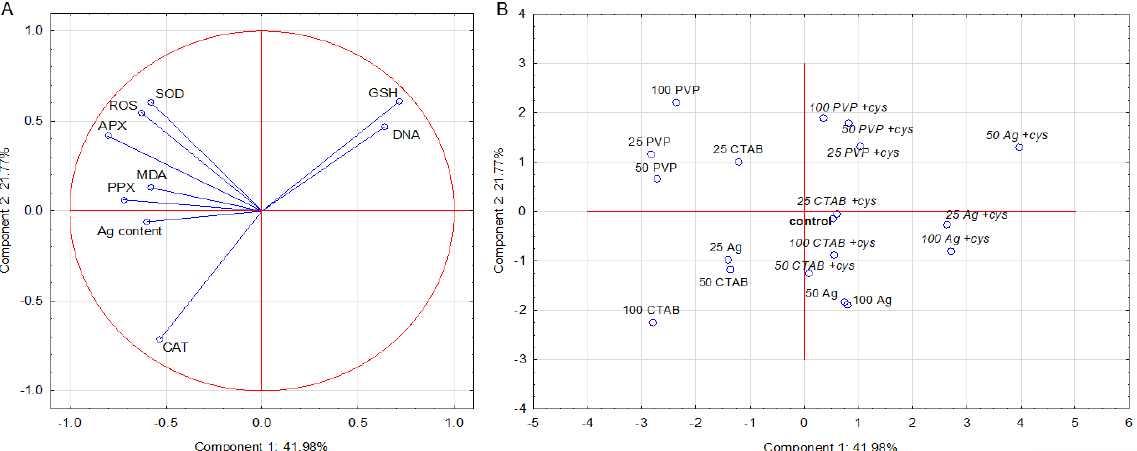
Figure 3. Principal component analysis of root data set obtained for tobacco plants 7 days after ex- posure to 25, 50, and 100 μM AgNP– PVP, AgNP – CTAB, and AgNO 3 , applied either alone or in combination with cysteine (+ cys). ( A ) loadings and ( B ) scores of the first two components (PCs). Silver (Ag) content, reactive oxygen species content (ROS), malondyaldehide content (MDA), glu- tathione content (GSH), DNA damage (DNA), activity of superoxide dismutase (SOD), ascorbate peroxidase (APX), pyrogallol peroxidase (PPX), and catalase (CAT) represent variables that contrib- uted the most to the combined PC1/PC2.